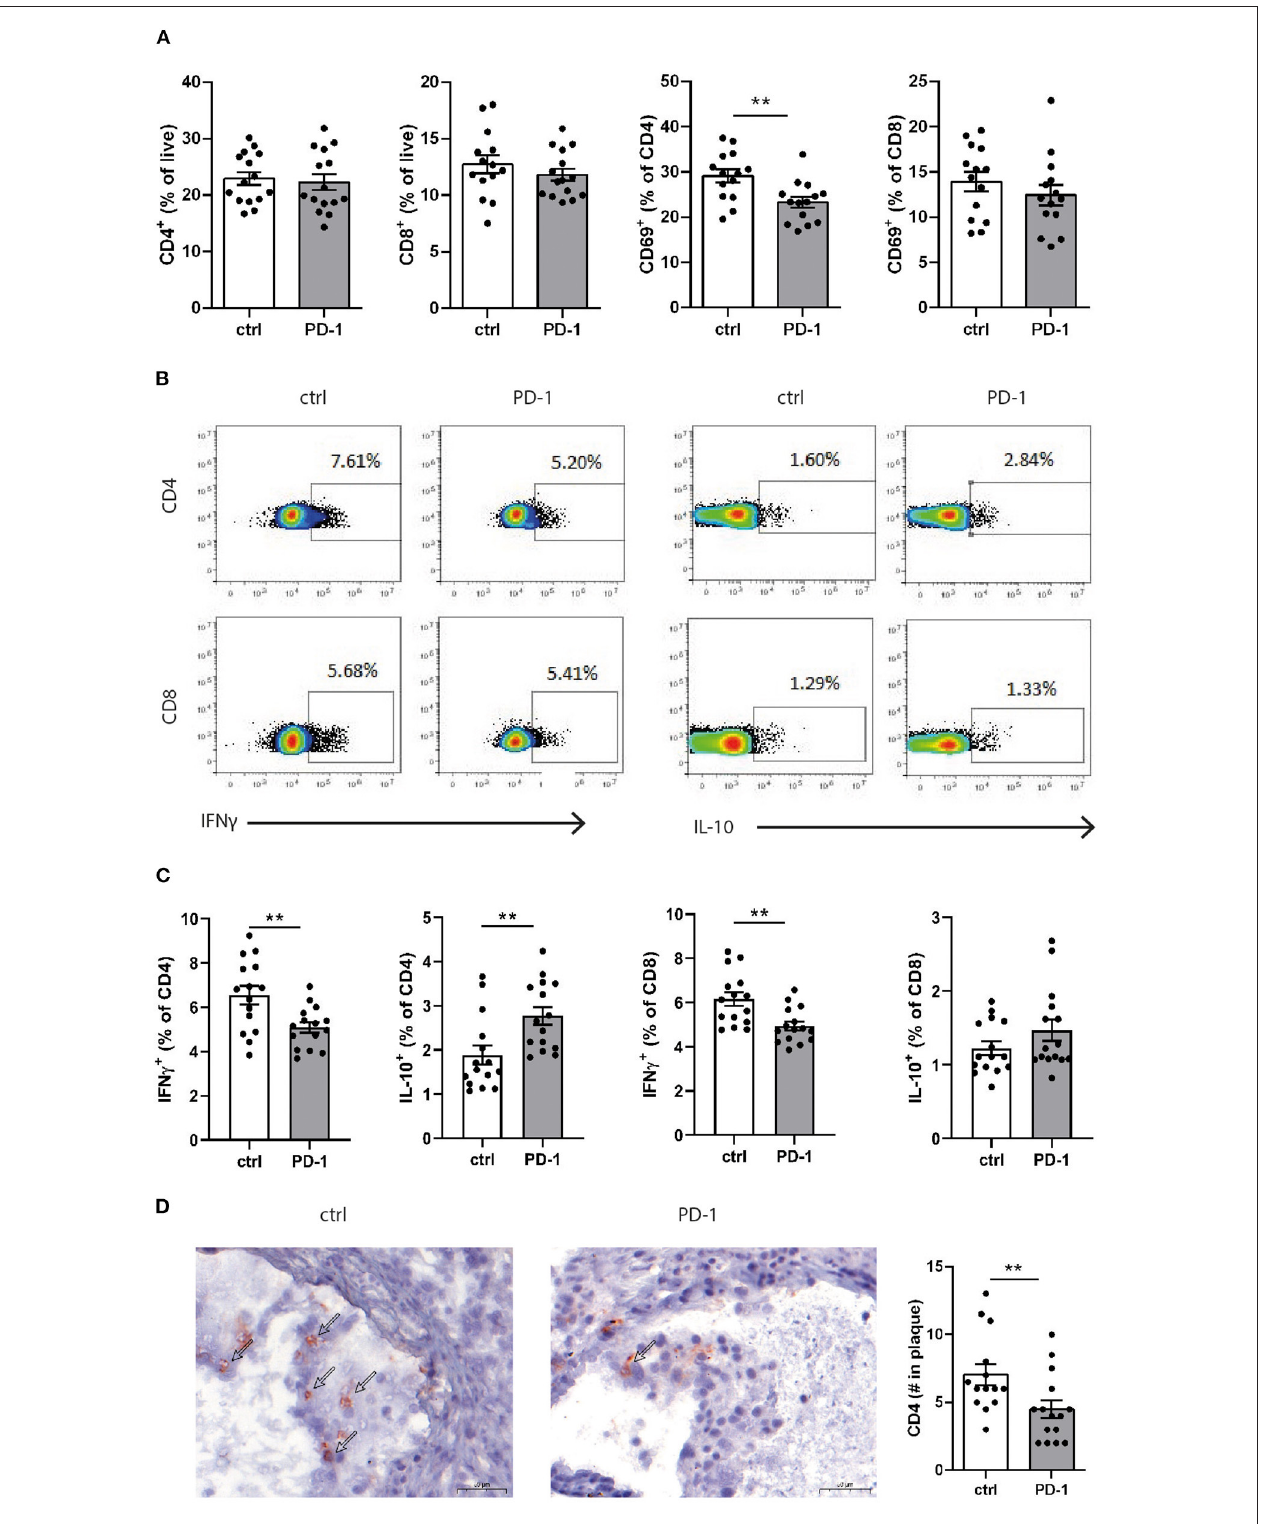
FIGURE 3 | PD-1 stimulation promotes an anti-atherogenic T cell phenotype. (A) The amount of CD4 + and CD8 + T cells and their expression of CD69 was measured in splenocytes by flow cytometry. To measure intracellular cytokines, splenocytes were stimulated for 4h with PMA/ionomycin and BrefA. (B) Representative dotplots and (C) data graphs of intracellular IFN γ and IL-10 within CD4 + and CD8 + T cells are shown. (D) CD4 + T cell numbers in the atherosclerotic plaque were manually scored. Scale bars indicate 50 µ m. Mean ± SEM are shown. Statistics was performed using unpaired T -test. P ≤ 0.05 are considered significant. ** p ≤ 0.01.